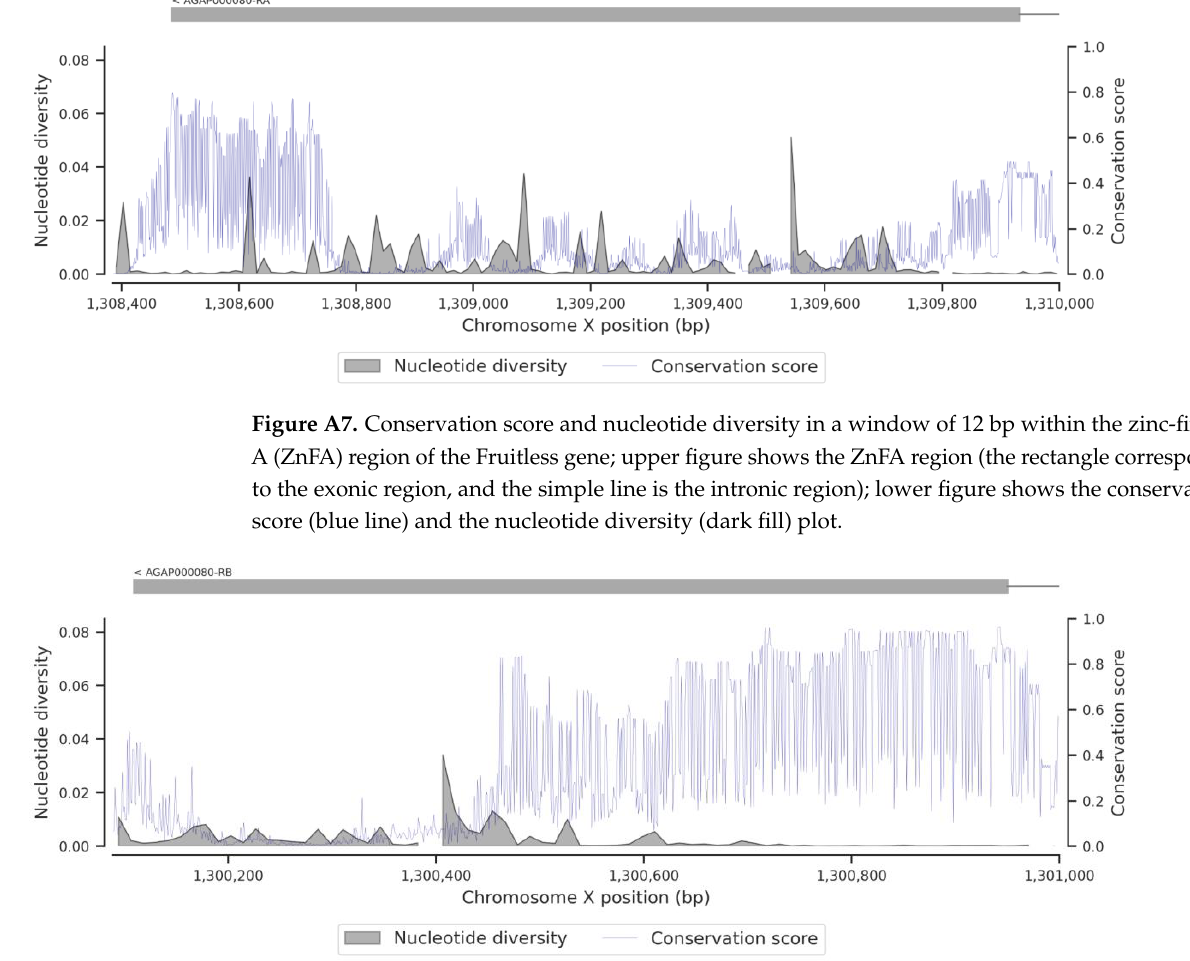
Figure A8. Conservation score and nucleotide diversity in a window of 12 bp within the zinc-finger B (ZnFB) region of the Fruitless gene; upper figure shows the ZnFB region (the rectangle corresponds to the exonic region, and the simple line is the intronic region); lower figure shows the conservation score (blue line) and the nucleotide diversity (dark fill) plot.